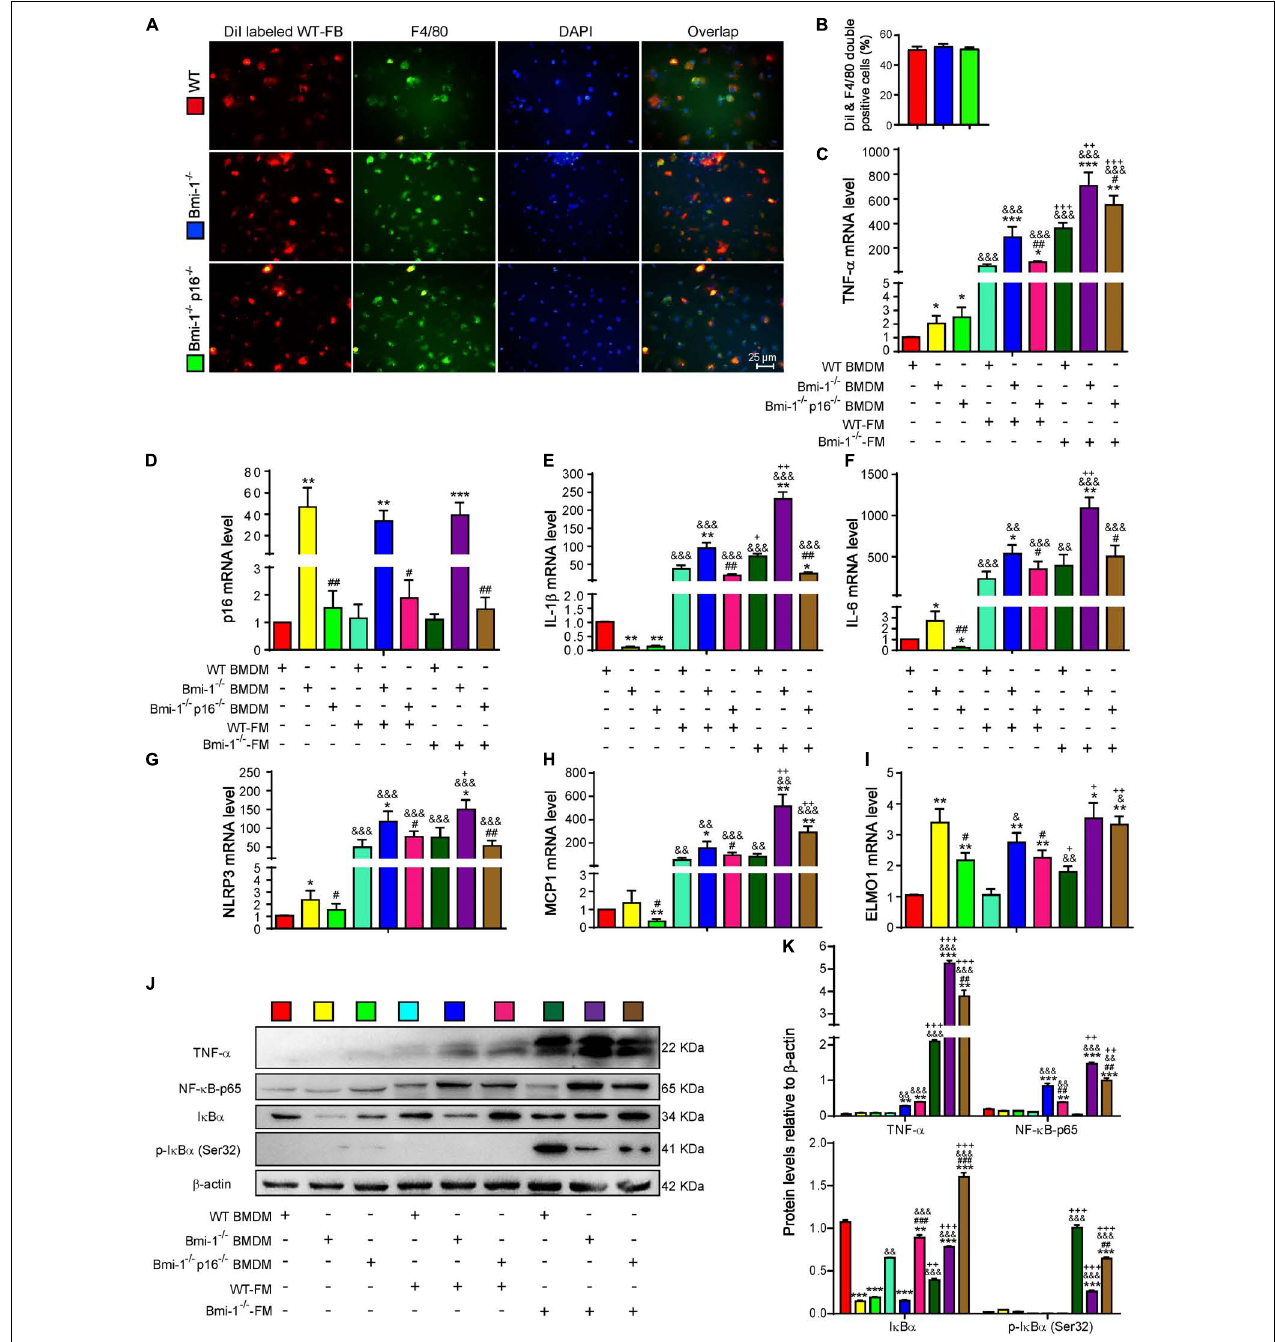
FIGURE 6 | P16 deletion improved up-regulated proinflammatory level of macrophages induced by change of intestinal microbiota ameliorated in Bmi-1 − / − mice. Fecal mixed bacteria (FB) were prepared using the fecal of 7-week-old WT and Bmi-1 − / − mice to infect BMDMs from WT, Bmi-1 − / − , and Bmi-1 − / − p16 − / − mice. (A) Representative micrographs showing immunofluorescence for F4/80 after Dil-labeled WT-FM–infected BMDMs, with DAPI staining the nuclei, red dots showing Dil-labeled WT-FB, and green dots showing F4/80. (B) Percentage of DiI and F4/80 double-positive cells. (C–I) Tumor necrosis factor ( TNF- α ), p16 , interleukin ( IL-1 β ), IL-6 , NACHT, LRR, and PYD domain–containing protein 3 ( NLRP3 ) and monocyte chemoattractant protein 1 ( MCP1 ) and engulfment and cell motility protein 1 ( ELMO1 ) mRNA levels in BMDMs by real-time RT-PCR, calculated as the ratio to β -actin mRNA and expressed relative to WT. (J) Western blots of BMDM extracts showing TNF- α , NF- κ B–p65, I κ B α , and p-I κ B α (Ser32); β -actin was used as the loading control. (K) Protein levels relative to β -actin were assessed by densitometric analysis. Cell experiments were performed with three biological repetitions per group. Statistical analysis was performed with one-way ANOVA test. Values are mean ± SEM from six determinations per group, * p < 0.05, ** p < 0.01, *** p < 0.001 compared with the WT group at the same treatment; # p < 0.05, ## p < 0.01, ### p < 0.001 compared with the Bmi-1 − / − group at the same treatment; & p < 0.05, && p < 0.01, &&& p < 0.001 compared with the same genotyped BMDMs of vehicle-FM group; + p < 0.05, ++ p < 0.01, +++ p < 0.001 compared with the same genotyped BMDMs of the WT-FM